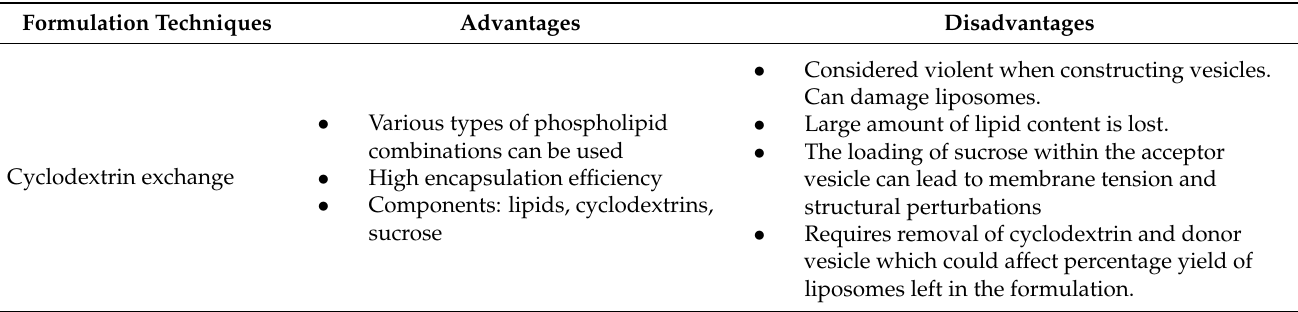
Table 3. Advantages and disadvantages of asymmetric liposomes formulation